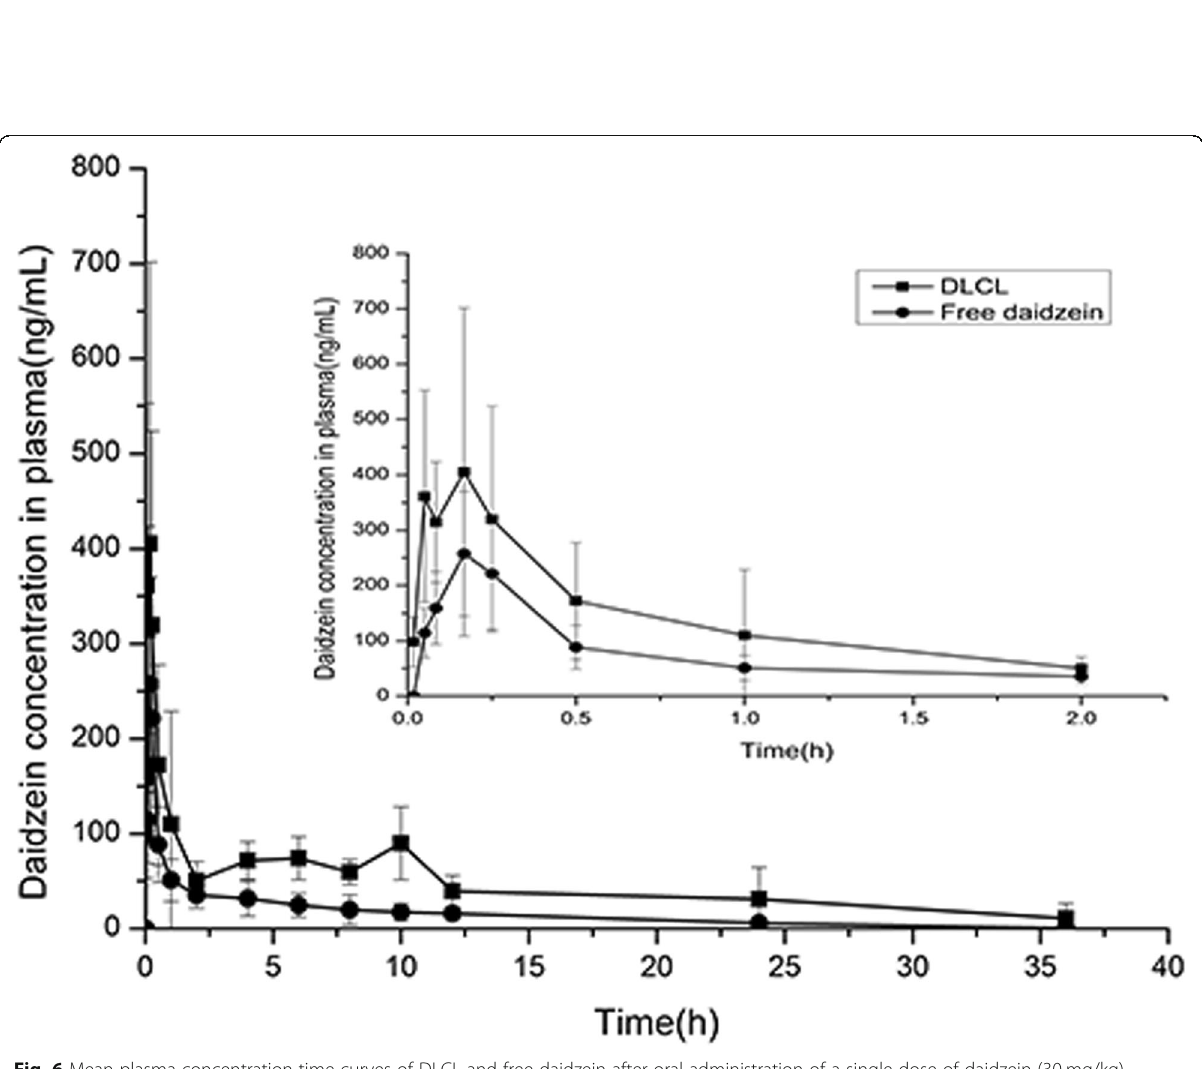
Fig. 5 In vitro release of DLCL and free daidzein at hydrochloride solution (pH 1.2) containing 0.5% Tween 80 ( a ) and phosphate buffer (pH 6.9) containing 0.5% Tween 80 ( b ) (mean ± SD, n = 3)